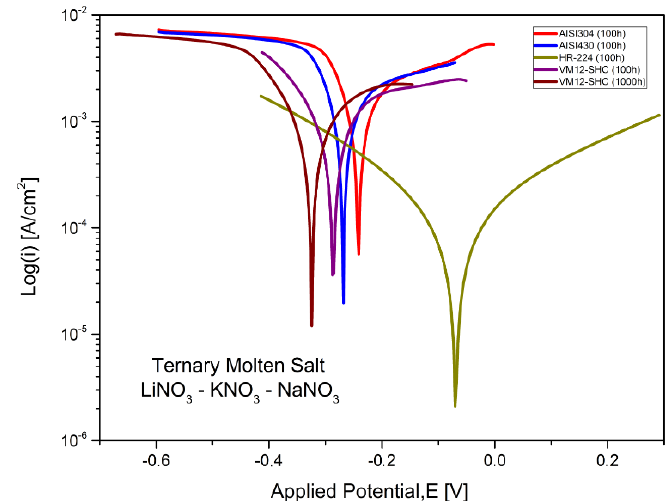
Figure 17. Polarization curves of stainless steel AISI 304, AISI 430, nickel ‐ based alloy HR ‐ 224 and ferritic steel VM12 in LiNaKNO 3 (ternary salt with lithium content) at 550 °C and 100 and 1000 h of exposure.